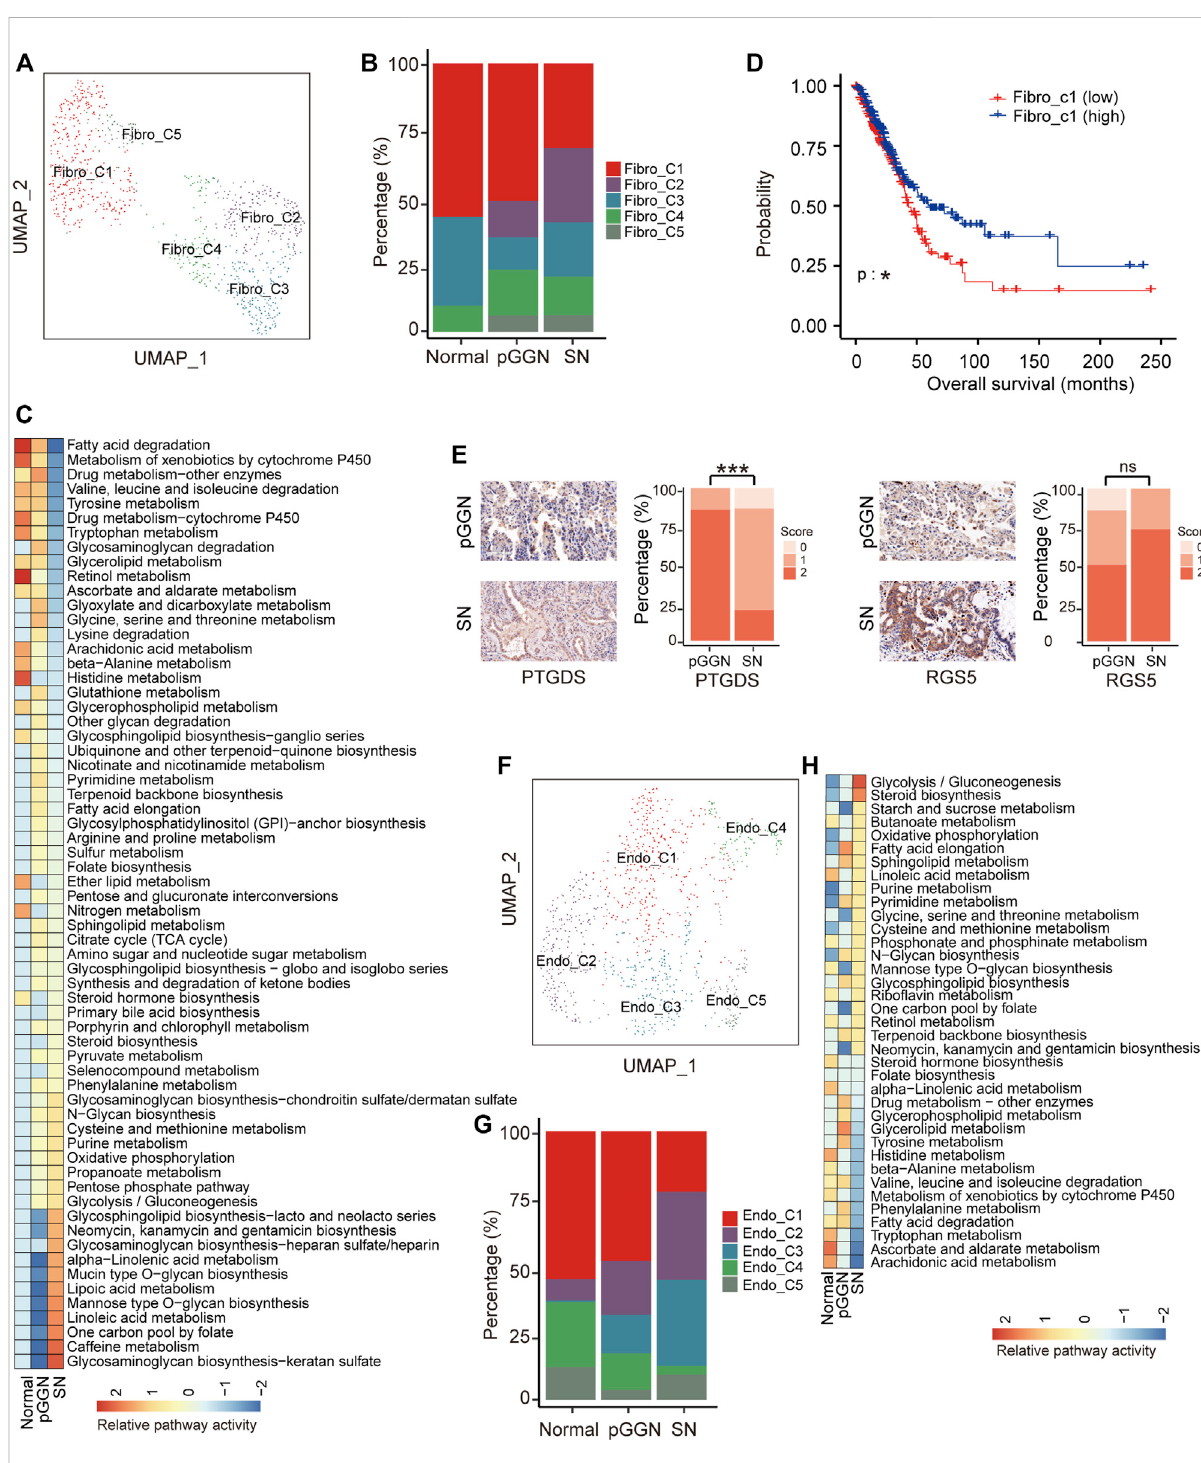
FIGURE 3 Stromal cells assist progression of tumor during the progression of LUAD. (A) UMAP plot of fi broblasts, colored by 5 cell subtypes. (B) The proportion of major cell subsets among each tissue origin. (C) Heatmap showing the activity of metabolic pathways for fi broblasts, among pure GGNs, SNs,and normal tissues. Many metabolic pathways wereupregulated in fi broblasts derived from SNs. (D) The survival curves of twogroups of TCGALUADpatientswithhighandlowexpressionofFibro-C1clustermarkergenes.The p -valuewascalculatedbytwo-sidedlog-ranktest. (E) The expression of PTGDS and RGS5 in the pure GGNs and SN tissues by immunohistochemical examination. The comparison was performed using t -test. (F) UMAP plot of endothelial cells, colored by 5 major cell types. (G) The proportion of major cell subsets among each tissue origin. (H) The enriched metabolic pathways by GSVA analysis in endothelial cells from different tissue origin. The scores were sorted by pathway activity in malignant cells from SN. ns, p > 0.05; *, p ≤ 0.05; **, p ≤ 0.001; ***, p ≤ 0.0001. A p -value < 0.05 was considered statistically signi fi